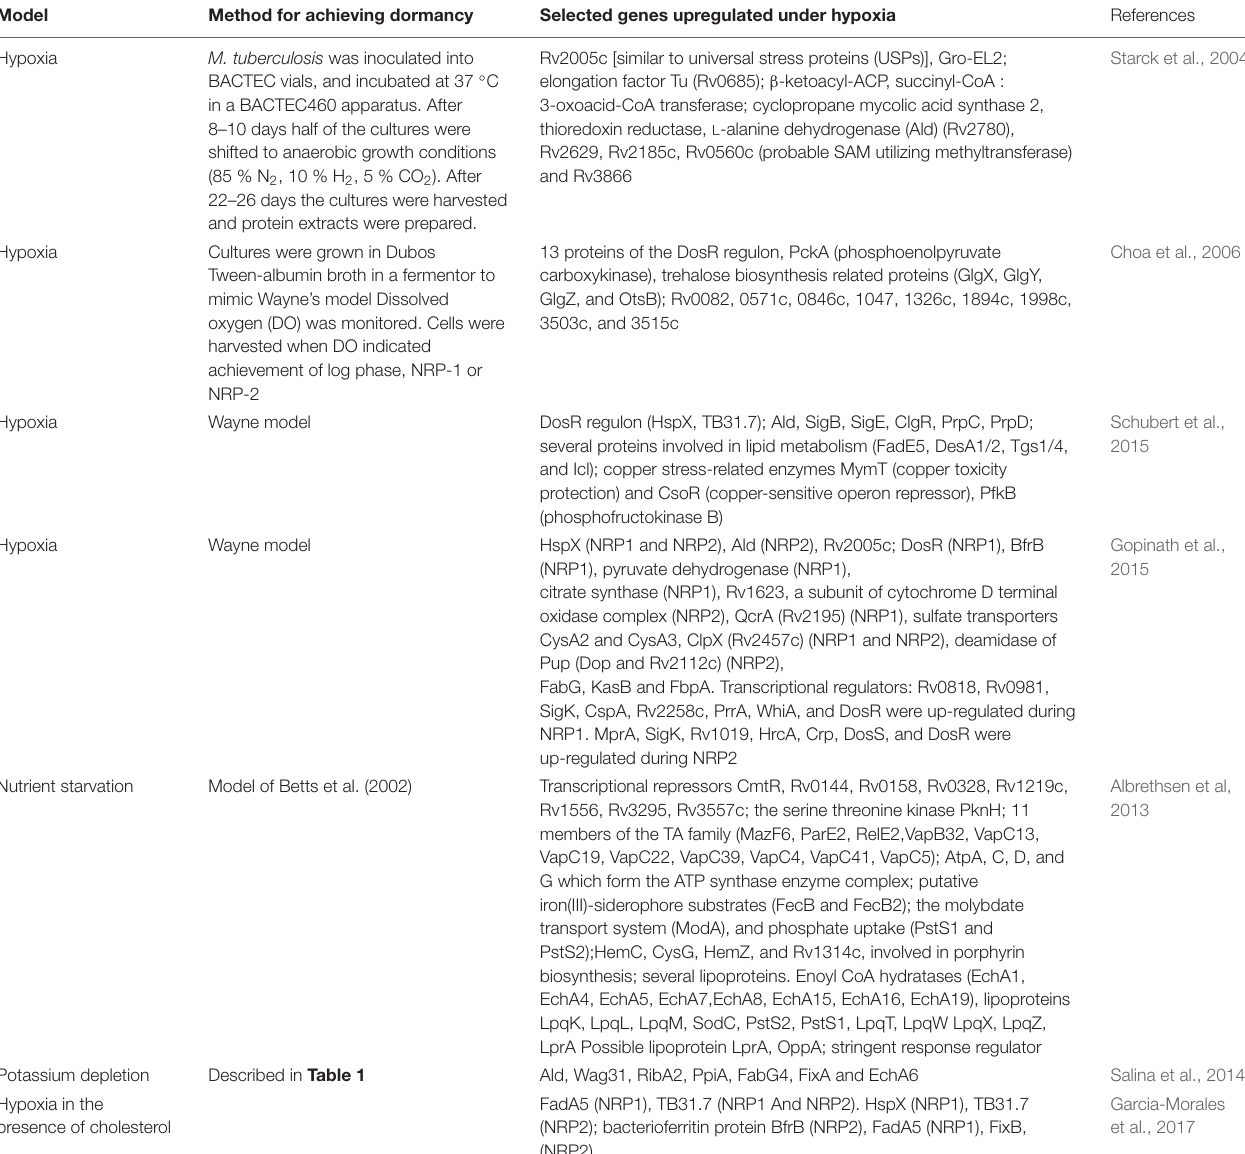
TABLE 2 | Mycobacterium tuberculosis proteins upregulated in in vitro models of